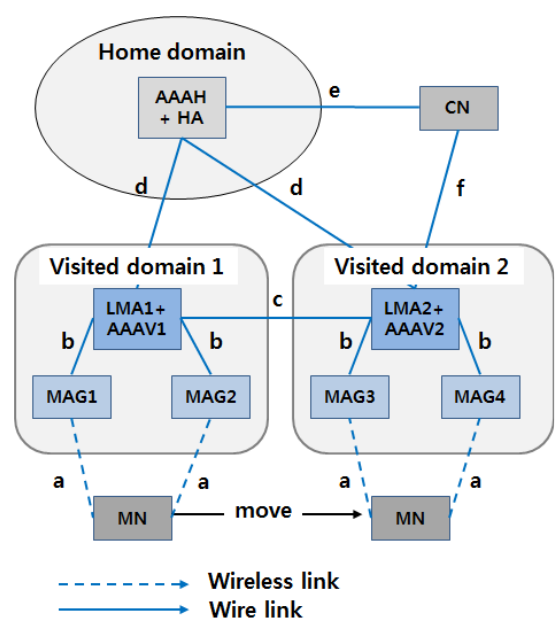
Figure 6. Cost analysis model of Proxy-AAA. data